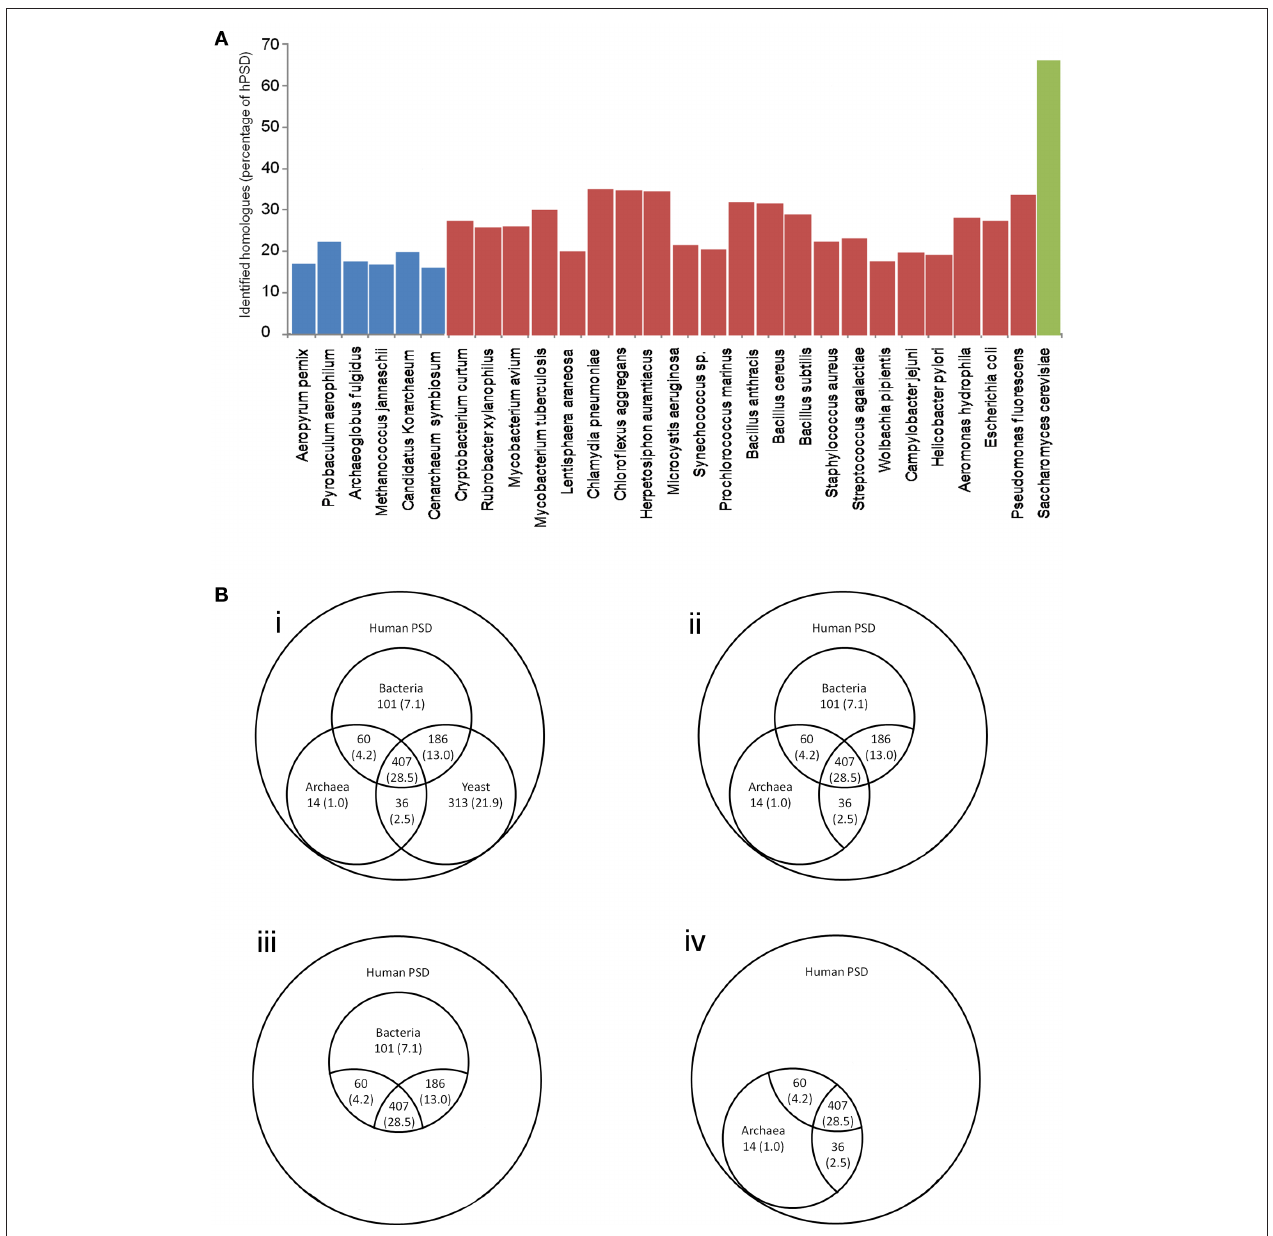
Figure 2 | Numbers of hPSD homologs in phylogenetic groups. (A) Histogram of homologs identified in each species tested as a percent of the human PSD dataset (blue archaea, red bacteria, green S. cerevisiae ). (B) i Comparison of number of identified hPSD proteome homologs across three superkingdoms, ii subset of i highlighting number of identified hPSD proteome